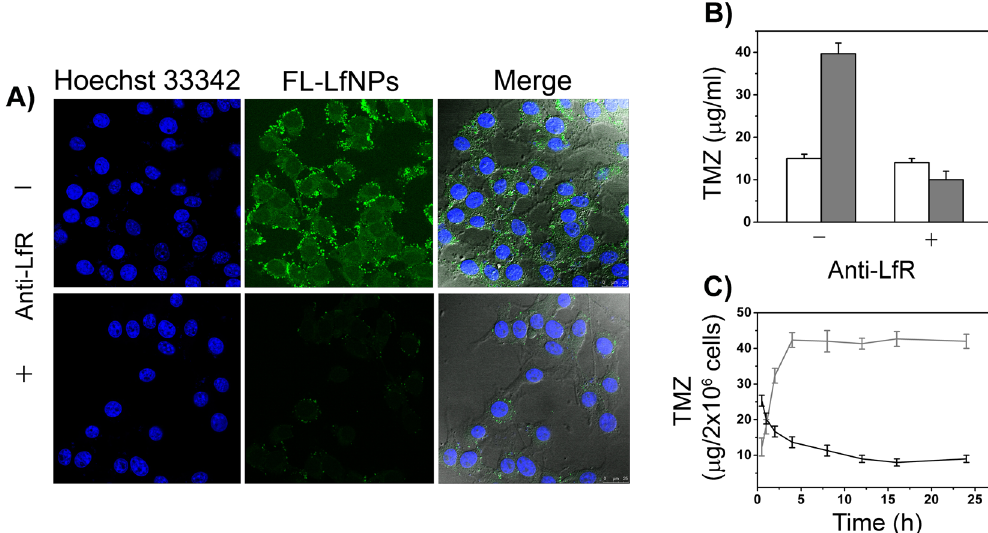
Figure 2. ( A ) FL-LfNPs uptake in GL261 cells in the absence (top panel) and presence (lower panel) of anti-LfR antibodies. (Scale bar = 25 µ m). (B) Intracellular TMZ concentration, obtained by treating GL261 cells with either free TMZ (white bars) or TMZ-LfNPs (gray bars) in the presence and absence of anti-LfR antibodies. ( C ) Comparative TMZ uptake and clearance by GL261 cells treated with either free TMZ (black curve) or TMZ- LfNPs (grey curve). Each data points were repeated in triplicates (n = 3) and presented as Mean ± Standard Deviation